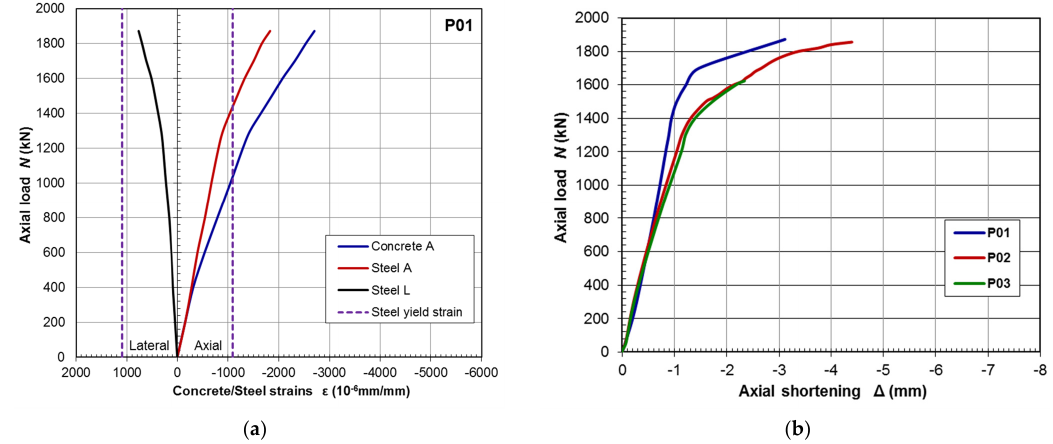
Figure 10. Measured axial load versus strains ( a ) and load versus deformation ( b ) relationships of the third group of strengthened specimens (P0x series). From the presented diagrams, it can be seen that, in the domain of exploitation loads or for forces up to 50% of crushing load, the behavior of all parts of the composite cross- section is linear. Pronounced nonlinear increase of deformations in relation to increasing of the loading was registered for forces above 80% of the crushing load. From diagrams, it can also be noticed that longitudinal strains on the steel tube (Steel A) and on the RC column (Concrete A) are equal for forces from 25% to 40% of ultimate force, and therefore, the full composite action is preserved in that load range. At higher stress states, different values of strains in concrete and steel yielded a conclusion that some slippage between parts of the composite cross-section parts had occurred. All strengthened specimens showed similar behavior; therefore, for one of them, the characteristic states are presented in Figure 11. It can be observed that the stress–strain curves showed a linear increase of deformations from the beginning of loading until the steel yielding started. Axial strains in strengthened specimens reached the steel yield strain before the specimen attained its ultimate strength, which indicates that the steel strength was fully utilized. The elastic steel limit was reached at around 1 mm of specimen shortening. That state was marked with point A. Further increase of the load caused stretching of the steel jacket, which had a consequence on the bonds between the steel tube, the concrete fill, and the basic RC column. Subsequently, the steel jacket could not provide efficient confinement to the fill concrete, which resulted in the crushing of the basic RC column, and the load-bearing steel plates started to push down into the concrete. When the load-bearing plates were fully embedded in the concrete, the top and bottom hydraulic press steel plates came into contact with the specimen. At that time, the load was applied to the column’s full cross-section, which is marked with point B. The ultimate load on the specimen is marked with point C. After the load was applied to the whole cross-section, the specimen was only able to take a relatively small increase of the force and had great development of deformation, before reaching its ultimate load (range from point B to point C).